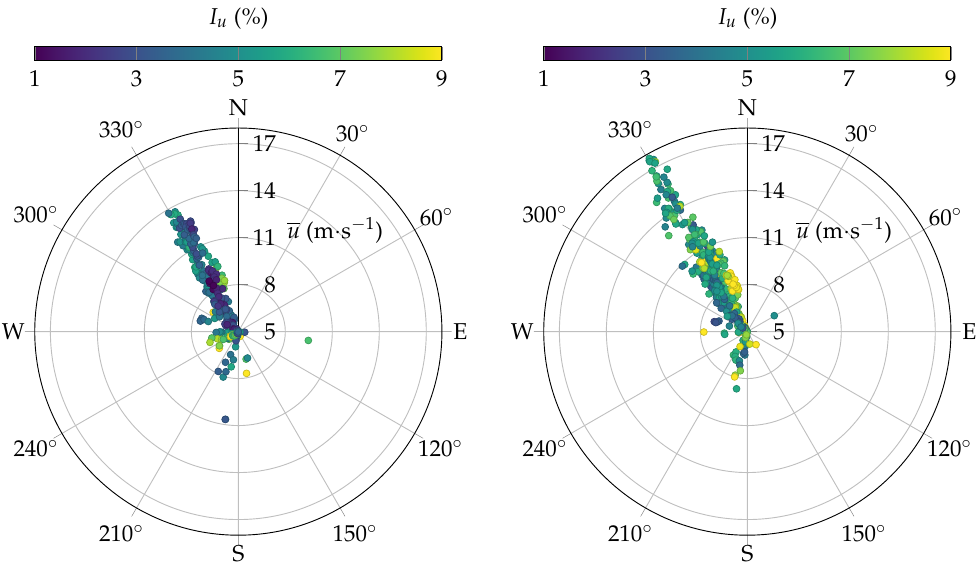
Figure 7. ( left ) Ten-minute mean wind velocity, direction and turbulence intensity recorded from 18 May 2016 to 21 June 2016 with the E-W configuration (326 samples with u Ten-minute mean wind velocity, direction and turbulence intensity recorded from 2016-06-07 to 2016-06-22 using the North-South configuration (437 samples with u